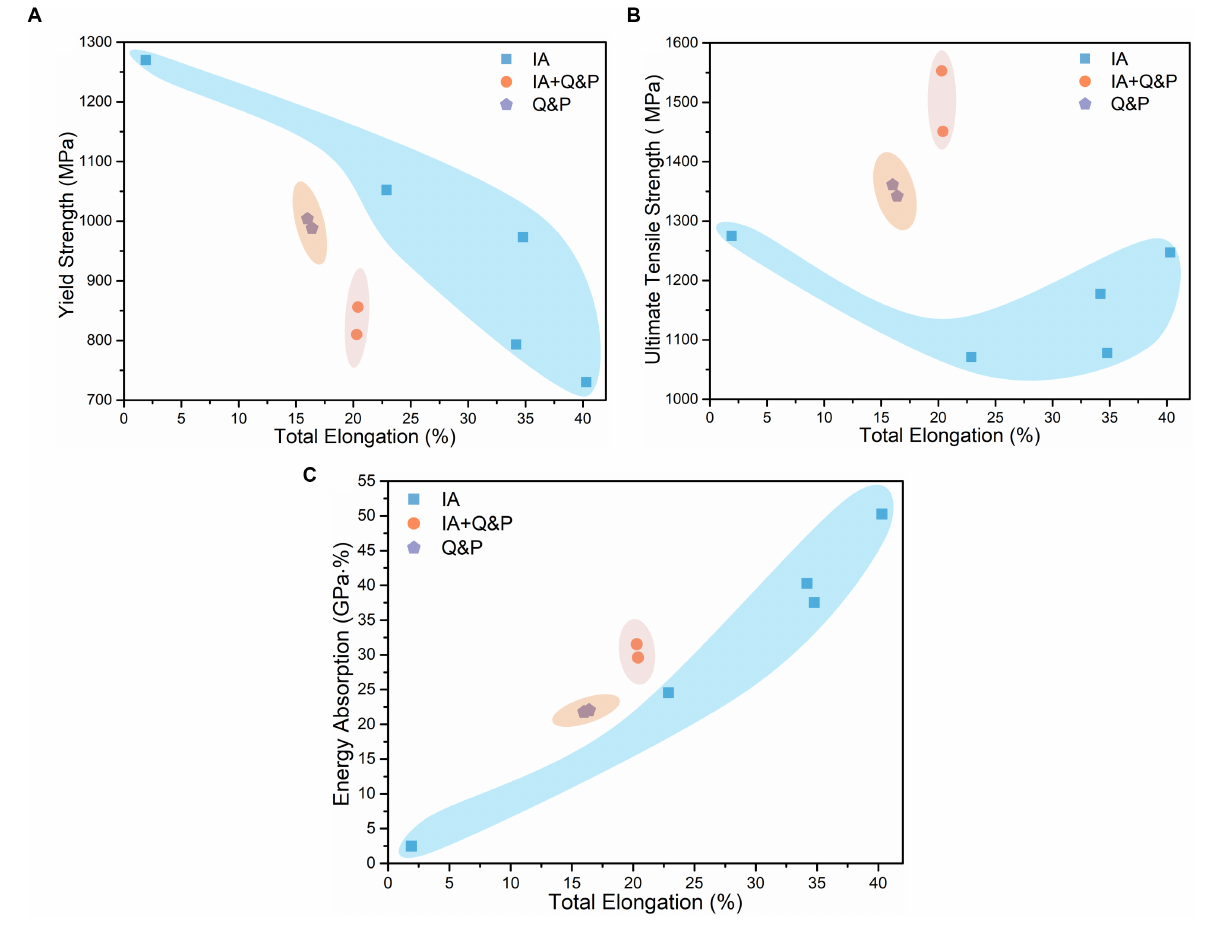
FIGURE 7 | The comparison of tensile properties of the IA, IA-Q&P, and Q&P steels. (A) Plot of yield strength against total elongation. (B) Plot of ultimate tensile strength against total elongation. (C) Plot of energy absorption against total elongation. Energy absorption is defined as the product between the ultimate tensile strength and total